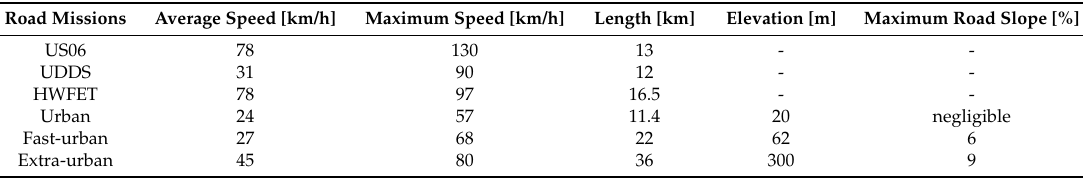
Table 2. Simulated road mission features.